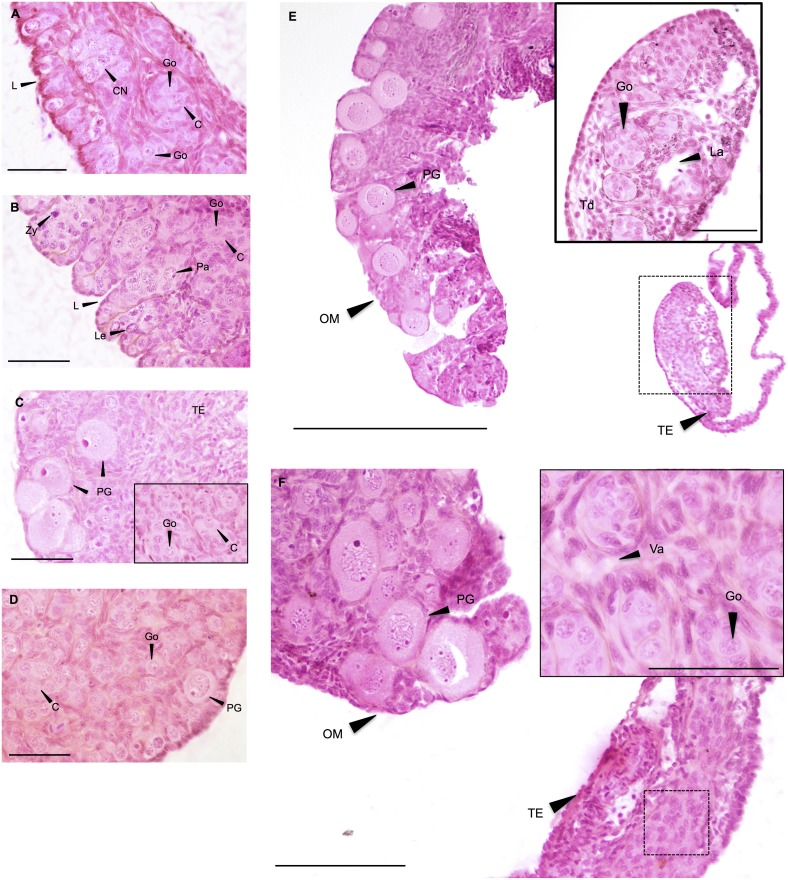
Intersex morphology.
A–B: Ovotestis 1. All-male rainbow trout testis at 136 dpf exposed chronically to 0.01 µg/L and 0.1 µg/L for 76 days. HES. L: lamellae; C: cords of gonocytes (Go); CN: cell nest in different meiosis stages: Le: leptotene; Zy: zygotene; Pa: pachytene. Scale bar = 50 µm. C–D:
Ovotestis 2. All-male rainbow trout testis at 136 days post fertilization (dpf) exposed chronically to 0.01 µg/L EE2 for 76 days. HES. Scale bar C = 50 µm, insert in C = 25 µm, D = 50 µm. Figure C shows oocytes appearance in an altered testis structure. The insert in Figure C shows the normal testis structure, with gonocytes (Go) organized in cords (C) observed in other areas of this gonad. Figure D shows oocyte appearance in a normal testis structure. PG: primary growth oocytes; TE: altered testicular tissue; FC: follicular cells. E–F:
Ovotestis 3. All-male rainbow trout testis at 136 dpf exposed chronically to 0.01 µg/L for 76 days. HES. Inserts show the altered testis structure at higher magnification. Dotted line represents the enlarged tissue section. OM: ovarian-like morphology; PG: primary growth oocytes; TE: altered testicular tissue; Sg: spermatogonia, La: lacune; Td: tubule disorganization; Va: vacuolation. Scale bar E = 300 µm, F = 100 µm, inserts = 50 µm.